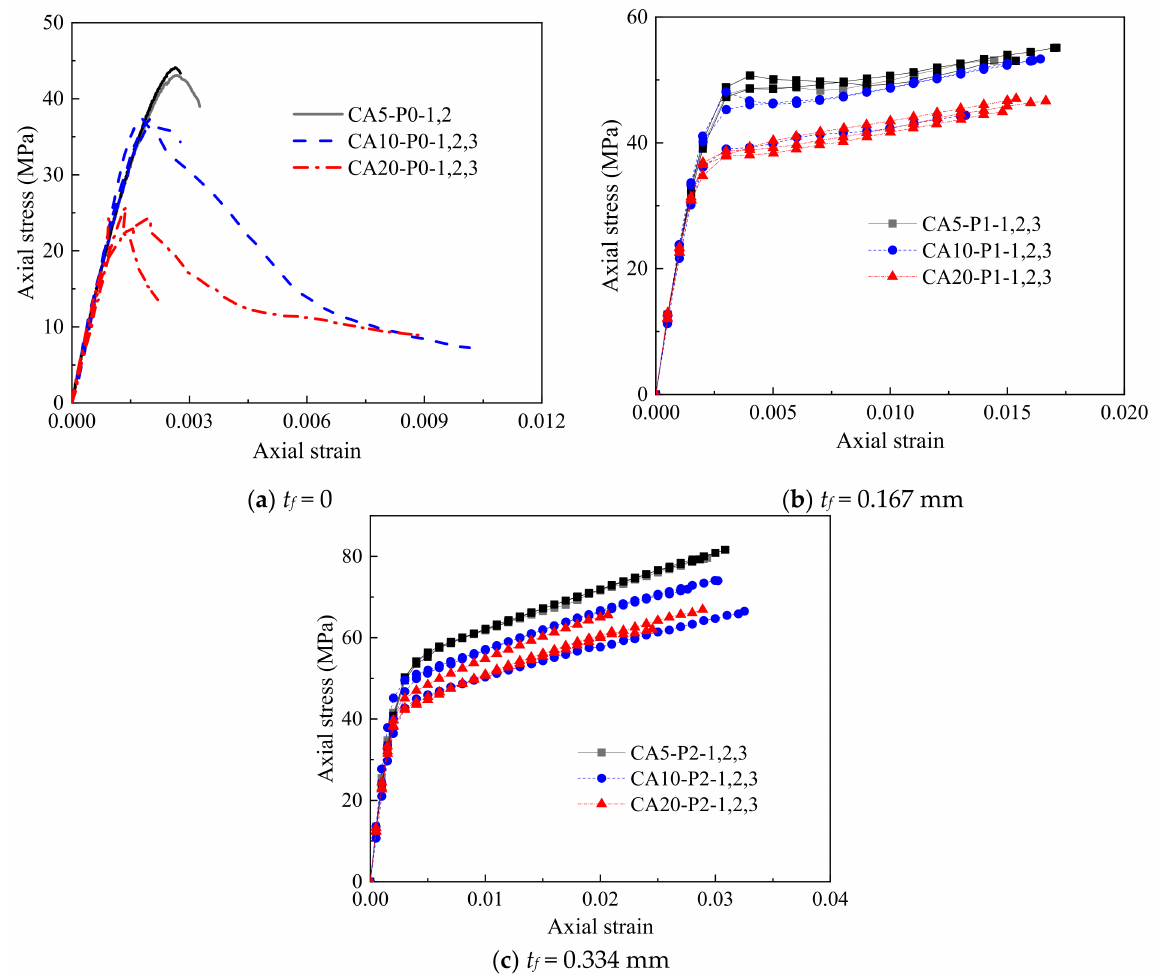
Figure 4. Effect of coral aggregate size on stress–strain behavior of confined